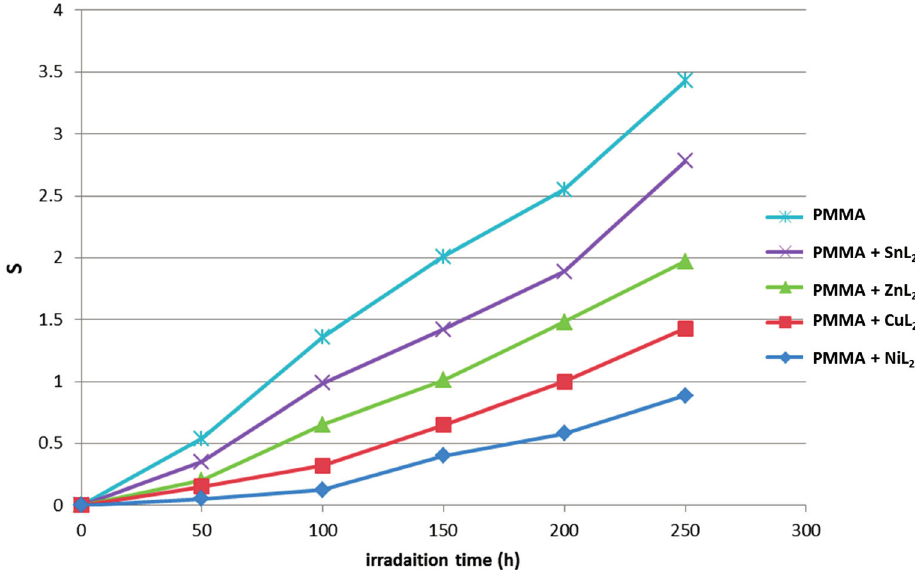
Figure 11. Changes in the main chain scission ( S ) during irradiation of PMMA films (40 μ m; control) and additives (0.5% by weight).